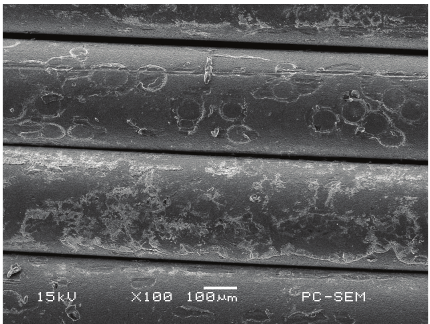
Figure 4: SEM image of the